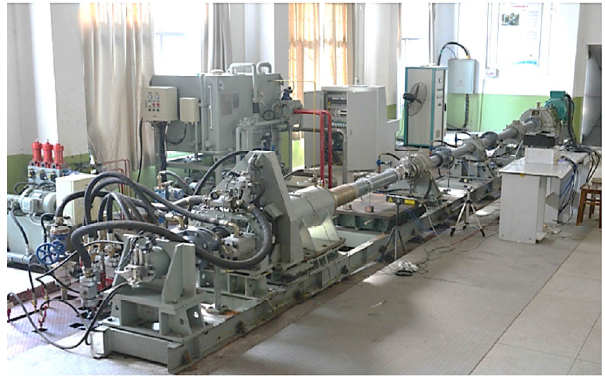
Fig. 14 Performance test platform for marine propulsion shafting